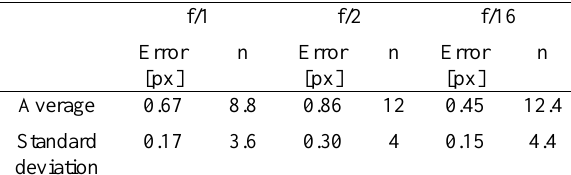
Table 4. Forensic Scene: Target error in Lytro image sets and the average of targets detected per set (n).